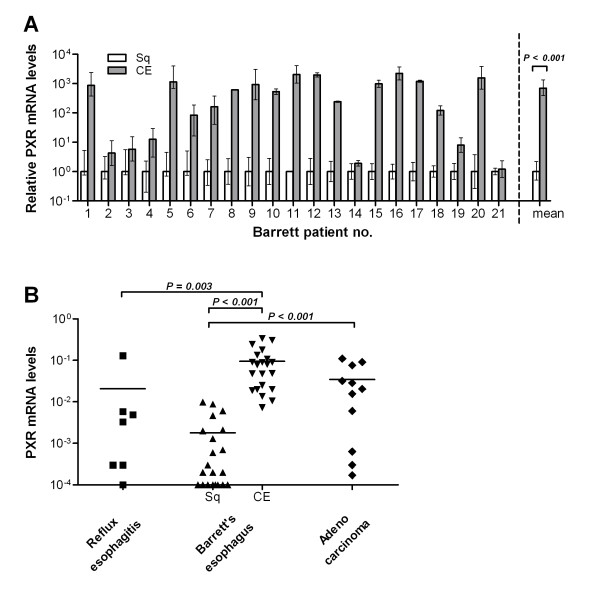
Relative mRNA levels of PXR in esophageal epithelium as determined by quantitative Real-Time PCR. (A) PXR levels in columnar epithelium (CE) are normalized to adjacent squamous epithelium (Sq) using 2(-ΔΔCt) method [23] and are plotted for each of 21 Barrett's esophagus (BE) patients. Error bars express a range which is a result of incorporating the standard deviation into the calculation. The mean of this population renders a strong significant increase of PXR mRNA levels in CE compared to Sq of BE patients (P < 0.001). (B) PXR mRNA levels are calculated using 2(-ΔCt) to show interindividual differences in PXR expression in RE, BE, and EAC patients and plotted on a log scale. Levels in Sq from patients with reflux esophagitis, and patients with BE are lower than in CE derived from the esophagus of BE patients (P = 0.003 and P < 0.001 respectively). mRNA levels in tissue from adenocarcinoma patients did not differ statistically from CE of BE patients, but was significantly higher than all Sq tissues. The detection limit for this assay was 0.0001.